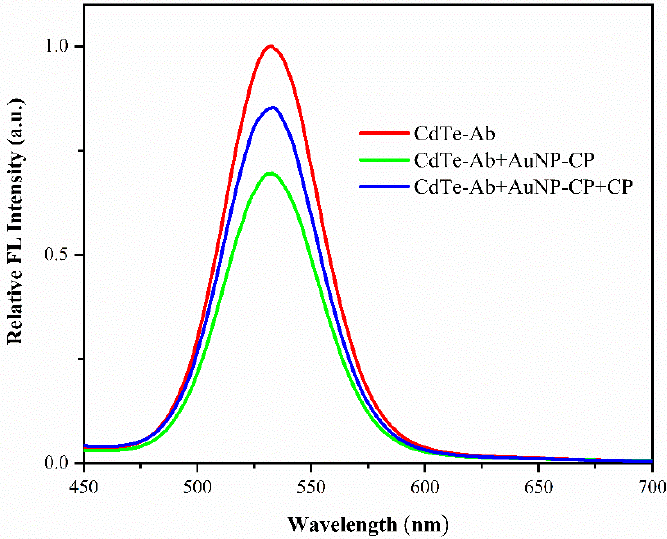
Figure 5. Fluorescence spectra of CdTe QD-Ab, CdTe QD-Ab + AuNP-CP and CdTe QD-Ab +